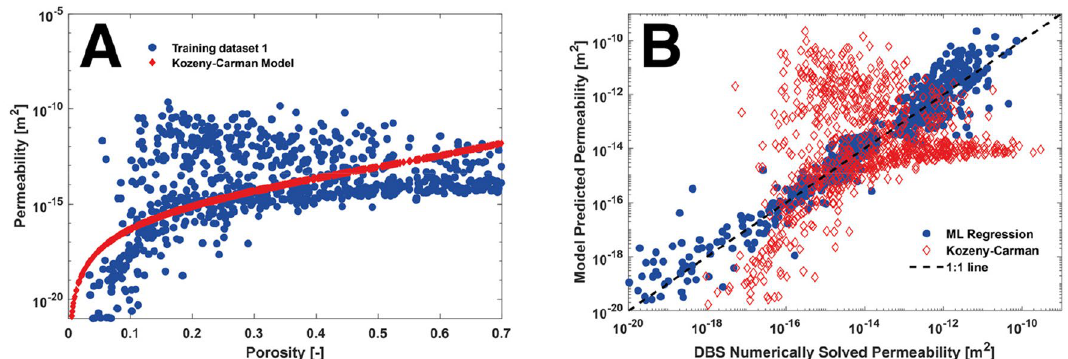
Figure 2. ( A ) The porosity and numerically solved permeability for each of the 30,000 sub-volumes of 60 3 voxels in training set 1 (blue) and the Kozeny–Carman fit (red) where K = 8.47 × 10 machine learning regression model predicted permeability (blue) and the Kozeny–Carman permeability (red) plotted against the DBS solved permeability for 1000 sub-volumes of 60 3 voxels. Data in this figure was computed using OPENFoam 46 and SciKitLearn 41 and rendered using MATLAB 48